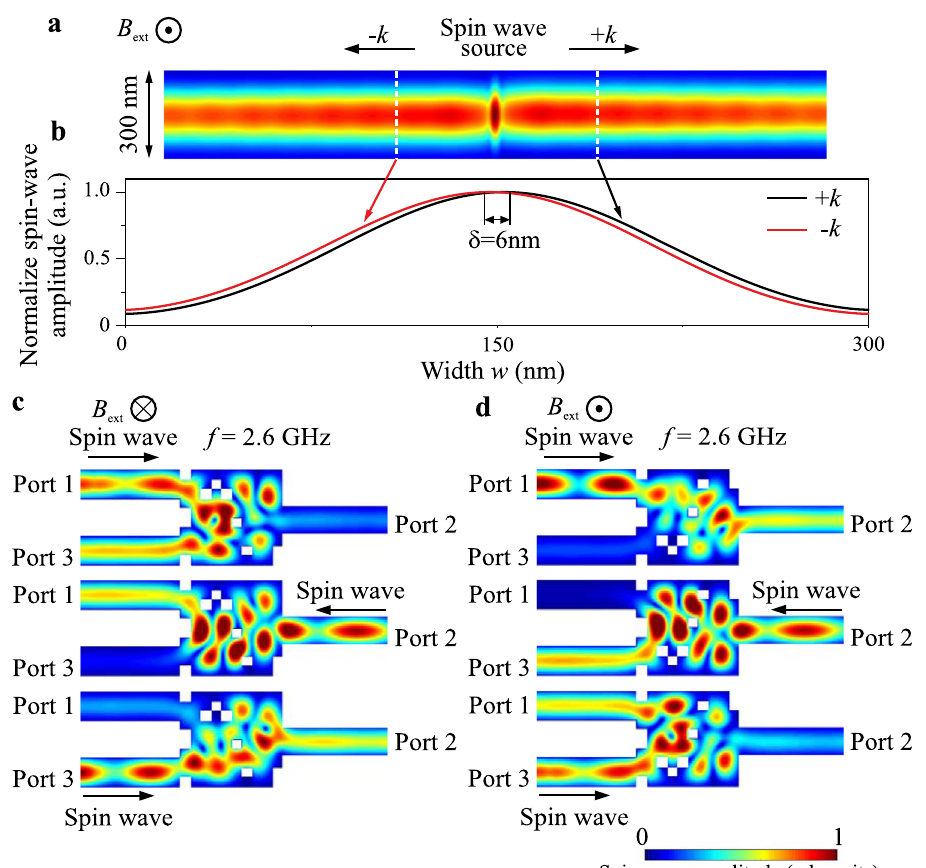
Fig. 6 Physical phenomena behind the nonreciprocity of FVSWs. a The normalized spin-wave amplitude in the single waveguide. Spin waves are excited in the middle of the waveguide and propagate in opposite directions. b The spin-wave pro fi les along the width of the waveguide for the positive and negative wavenumbers extracted from the regions as marked with the dashed white lines. The weak localization of the waves closer to one of the waveguide edges depending on the propagation directions is visible. c , d The normalized spin-wave amplitude in the same circulators with ( c ) inverted external fi eld direction (the functionality 3 → 2 → 1 → 3 is achieved) and ( d ) with the original fi eld direction like in Fig. 5a but with the fl ipped design structure along y -axis (the functionality 1 → 2 → 3 → 1 is achieved). The results show that nonreciprocal behavior is associated with the gyrotropic magnetization precession motion and breaking of time